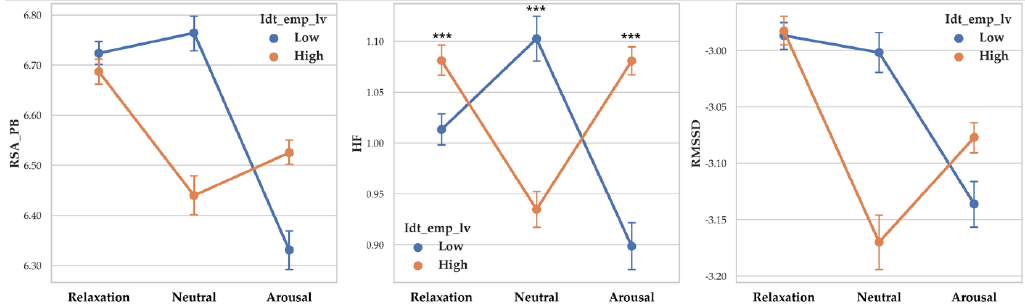
Figure 9. Point graph of vagal response depending on identification empathy level when participant empathized with arousal levels. Idt_emp_lv refers to identification level. Point means mean of vagal responses. Asterisk means significant vagal responses difference according to identification empathy level. (***: p < 0.001).